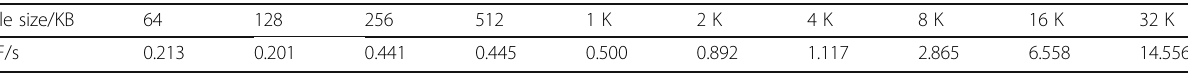
Table 7 The time cost of ownership proof based on